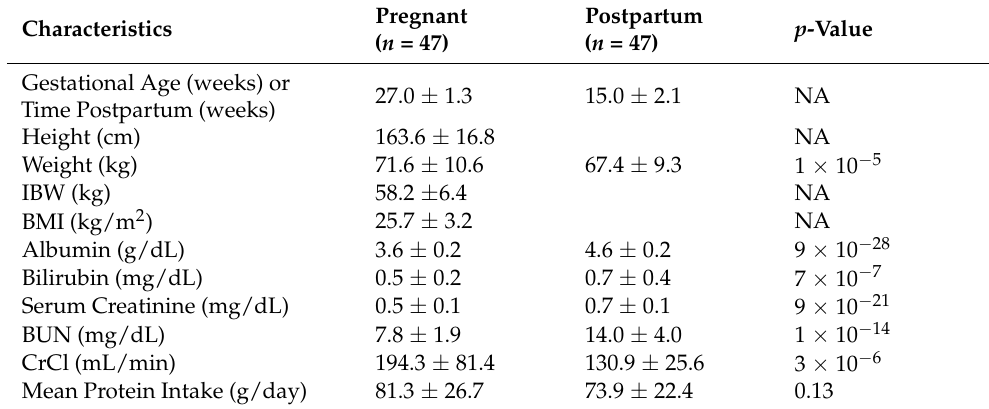
Table 1. Characteristics of subjects during pregnancy and